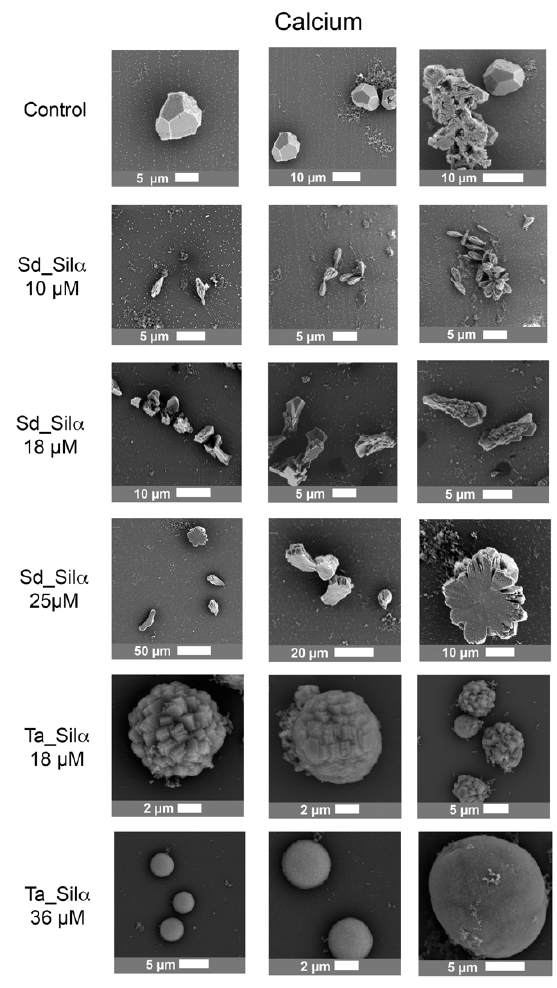
Figure 3. Selection of SEM micrographs from calcium silica carbonate biomorphs obtained at 25 ◦ C in the presence of different concentrations of silicatein- α . Sd_Sil α — Suberitis domuncula silicatein- α , Ta_Sil α — Tethya aurantia silicatein- α